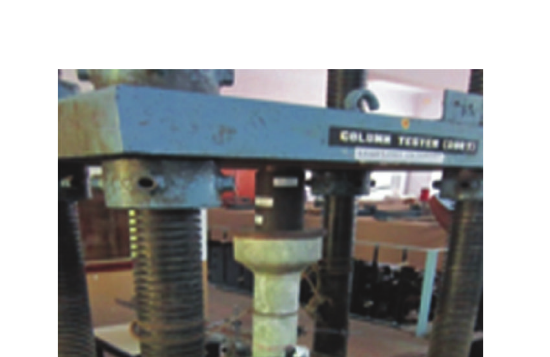
Figure 1: Reinforcement details.